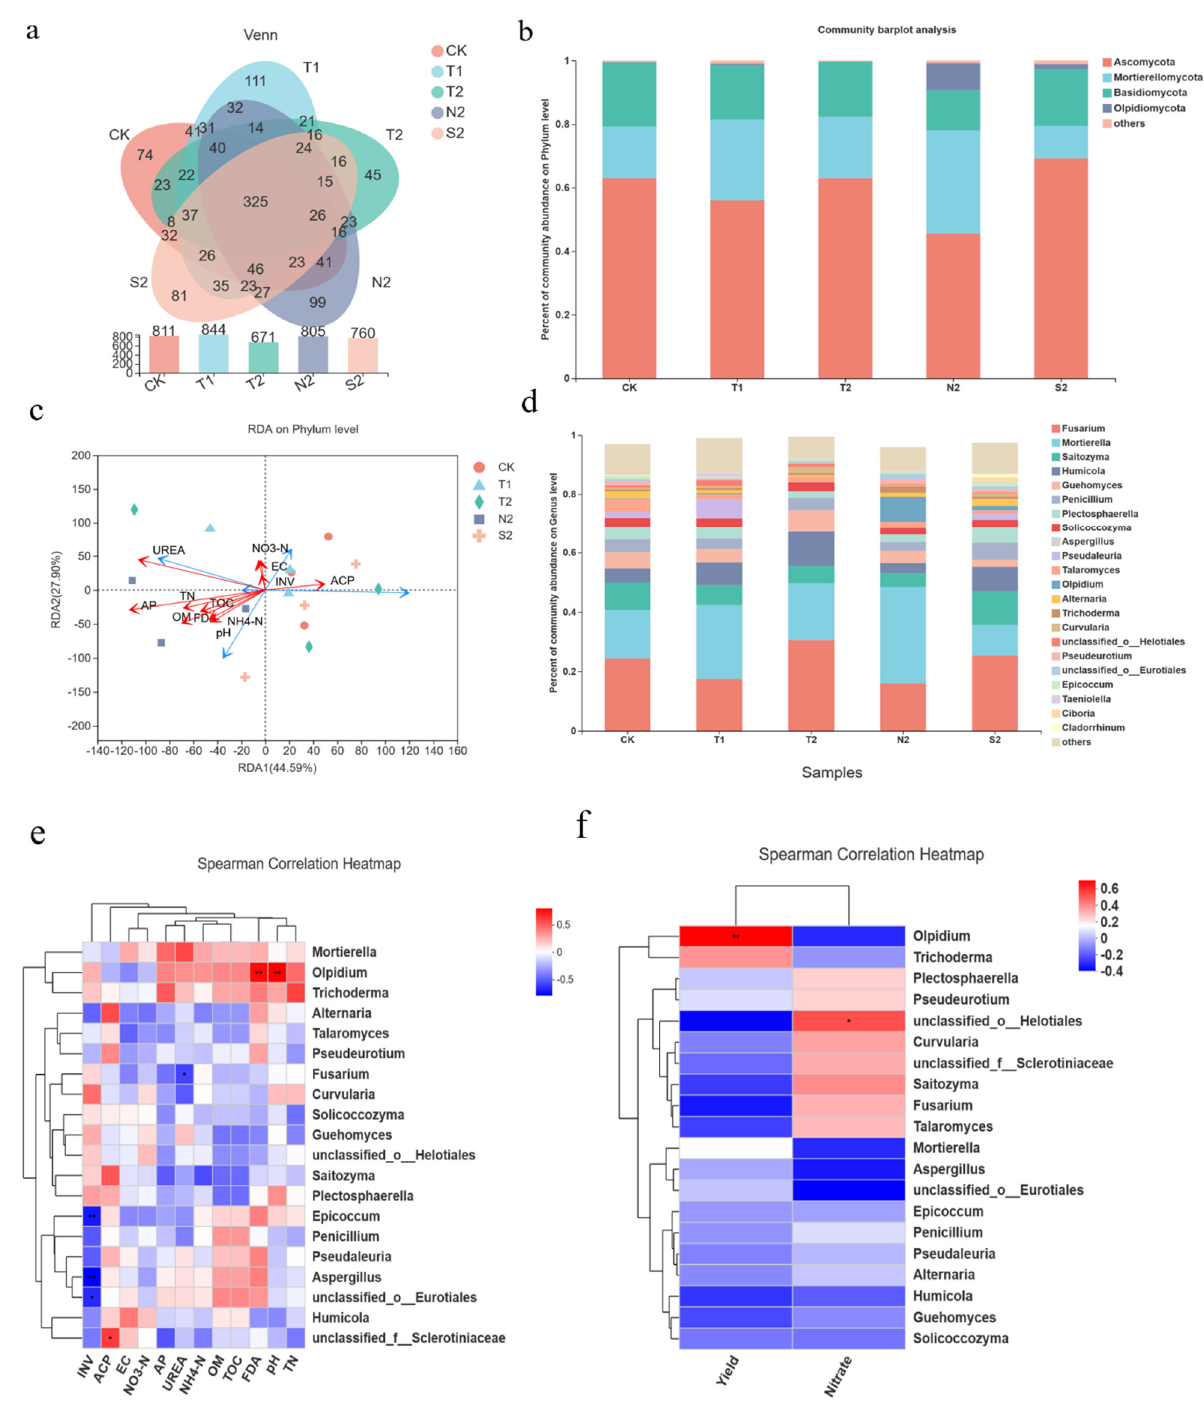
Figure 3. Number of common and unique OTUs based on fungal ( a ) Venn analysis; relative abun- dances of fungi ( b ) at the phylum level; redundancy analysis of the five (blue line) dominant fungi ( c ) associated with soil properties; relative abundances of fungi ( d ) at the genus level; the heatmap of the correlation with the top 20 dominant fungal ( e ) genera associated with soil properties; the heatmap of the correlation with the top 20 dominant fungal ( f ) genera associated with yield and nitrate content. Note: * at the 0.05 level (double-tailed), the correlation between them was significant; ** at 0.01 level